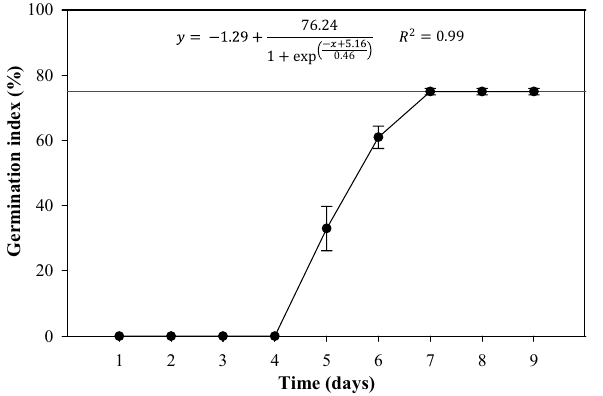
Figure 1. Average germination percentage of L. perenne seeds.